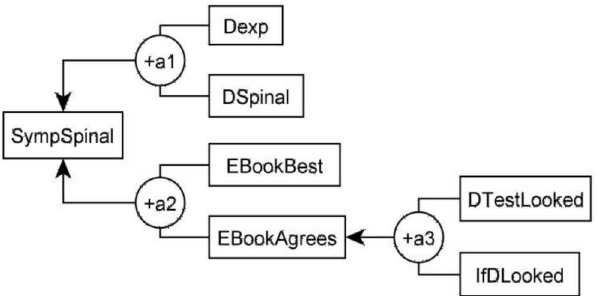
Figure 3. Argument Diagram of the First Part of the Expert Opinion